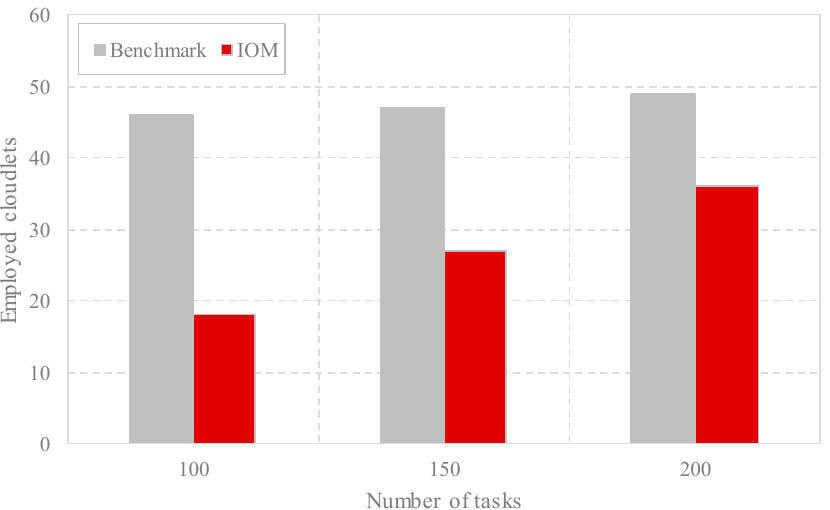
Figure 4. Comparison of the number of the employed cloudlets with different task scales by Benchmark and IOM.